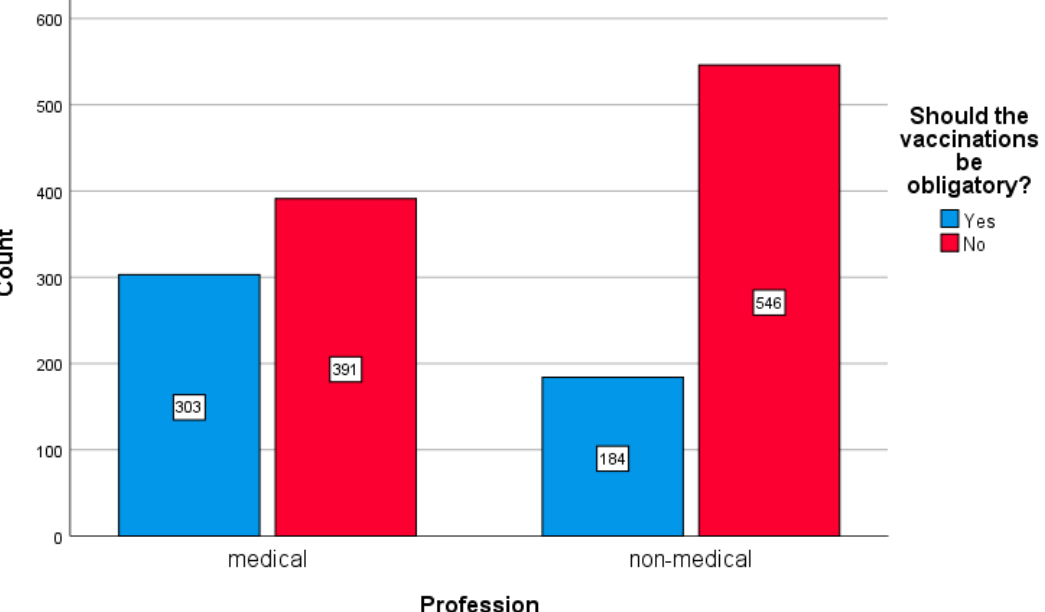
Figure 11. Differences in opinions concerning obligatory COVID-19 vaccination between the medical and non-medical groups.